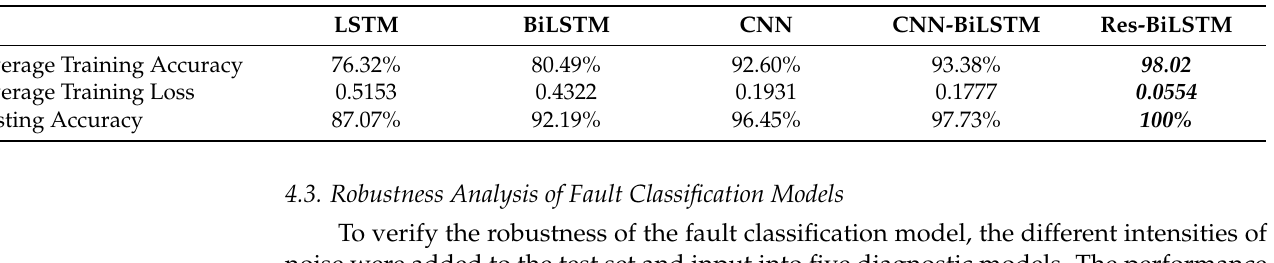
Table 3. Comparison of training performance of five learning frameworks.